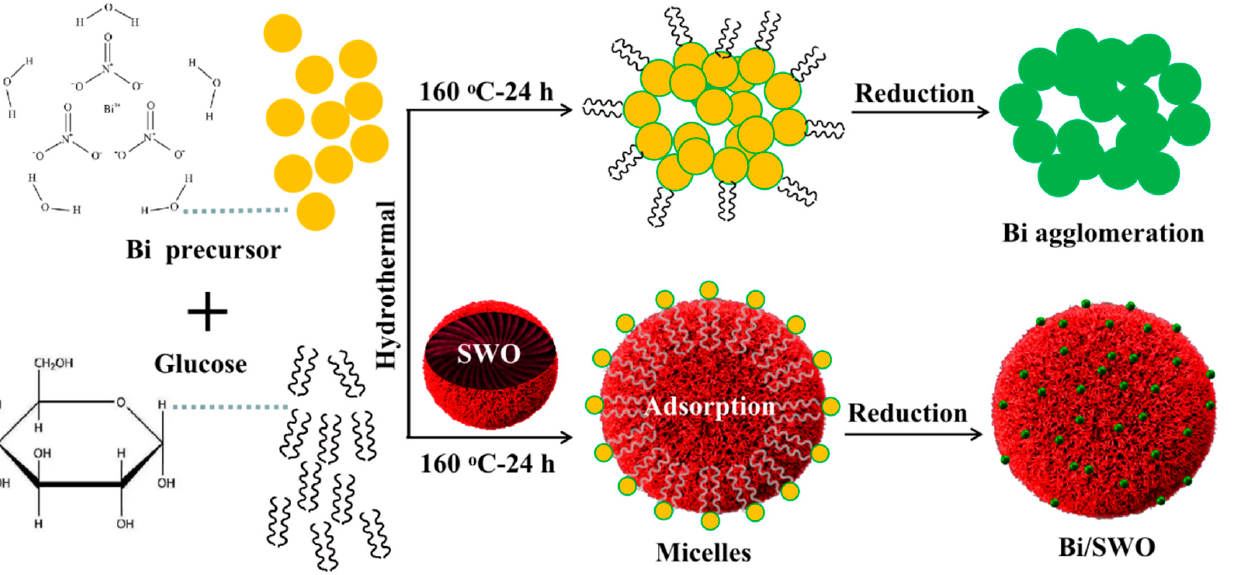
Figure 4 . Schematic illustration for the glucose-assistant growth mechanism of Bi/SWO. Figure 4. Schematic illustration for the glucose-assistant growth mechanism of